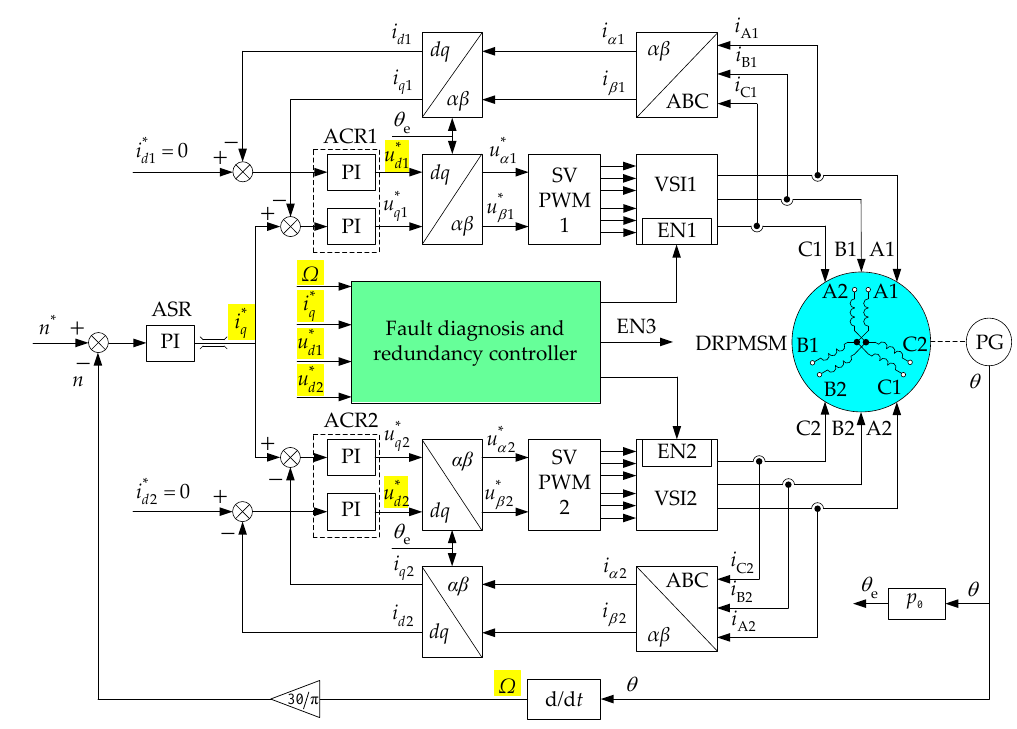
Figure 4. The control system block diagram of the DRPMSM.